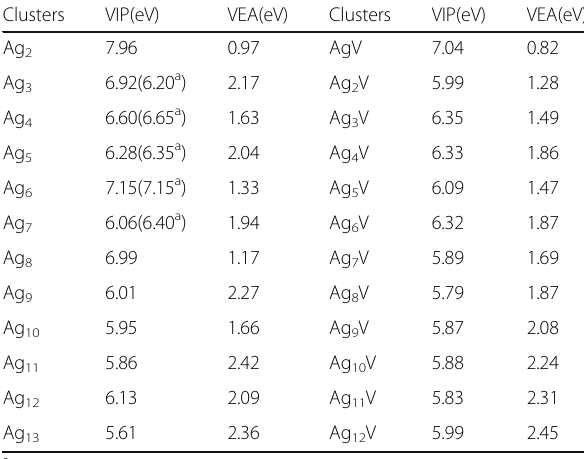
Table 3 VIP and VEA of the ground state Ag n +1 and Ag n V clusters. The data in parentheses are experimental findings